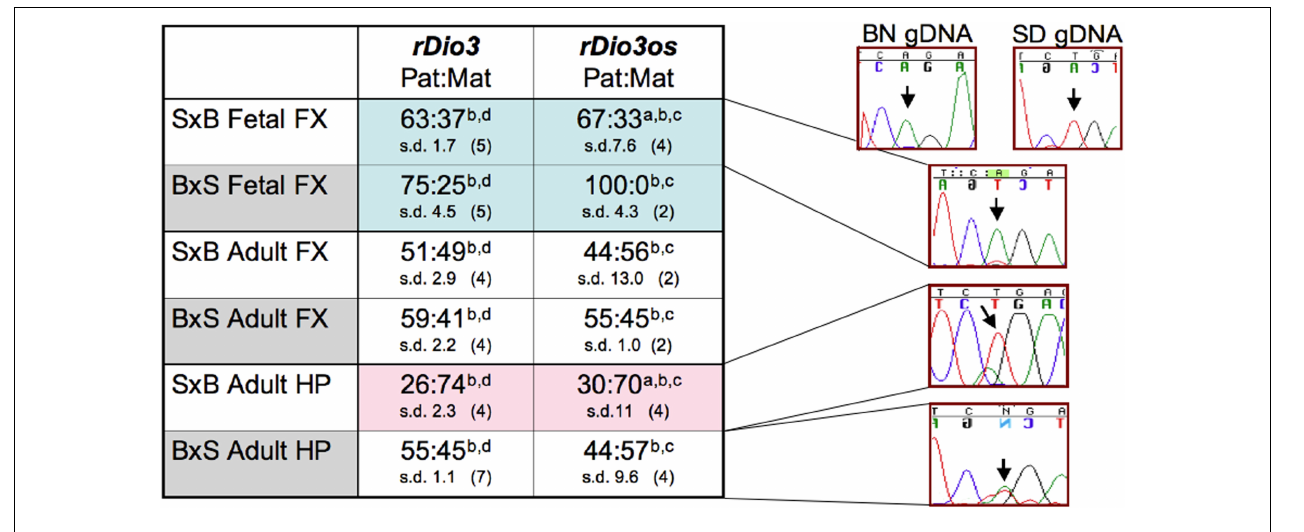
strand-specific or (b) random hexamer-primed RT-PCR, followed by (c) direct sequencing or (d) pyrosequencing analysis (Sittig etal., 2011a). For each cross, the maternal strain is given first (S × B or B × S). For allele-specific expression, paternal:maternal (Pat:Mat) expression ratios are given, along with representative preferential paternal, maternal or biallelic sequence traces. Strand-specific allele-specific analysis of rDio3os samples performed in duplicate-quadruplicate. s.d., standard deviation.